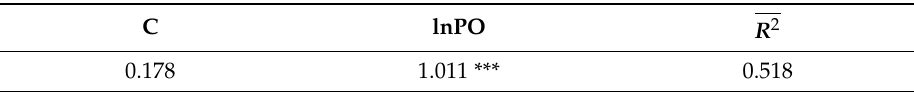
Table 4. First step regression results.